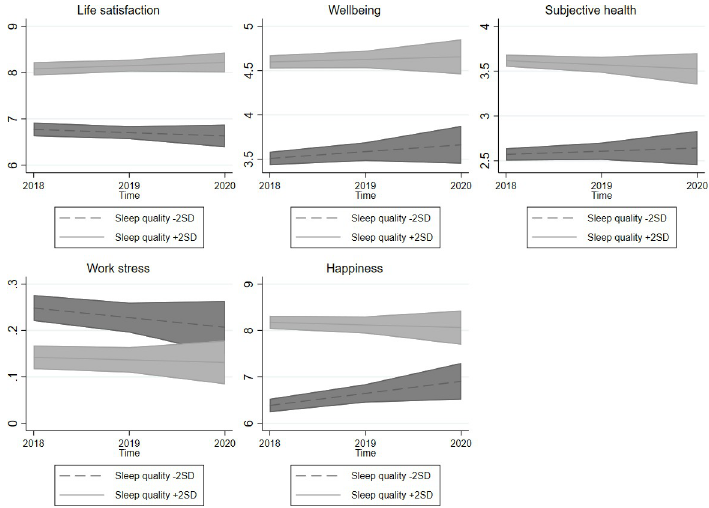
Fig 3. Sleep quality and quality of life at the individual level in time. Note: 95% confidence